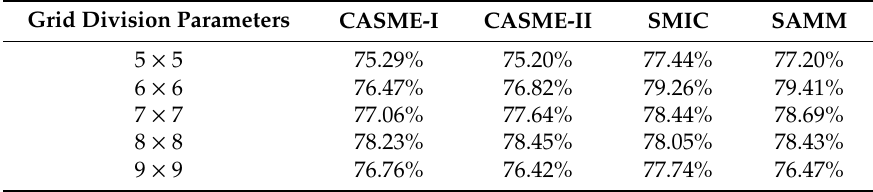
Table 3. Experimental results of the different grid division parameters on CASME-I, CASME-II, SMIC, and SAMM.